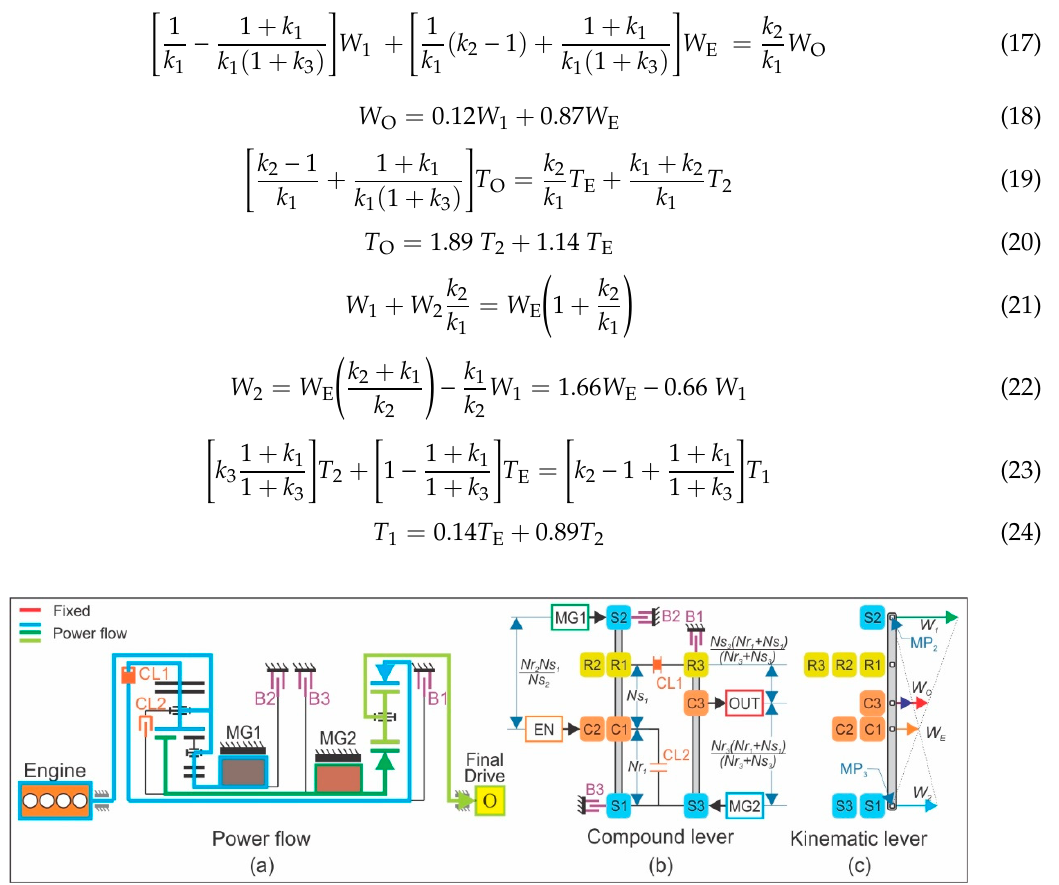
Figure 19. Compound-split mode.